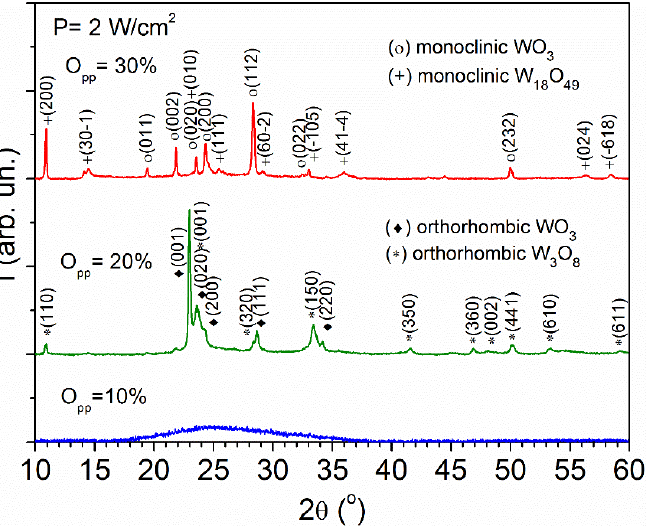
Figure 2. XRD patterns corresponding to WO 3 − x thin films prepared by reactive sputtering at 2 W/cm 2 and different oxygen partial pressures.